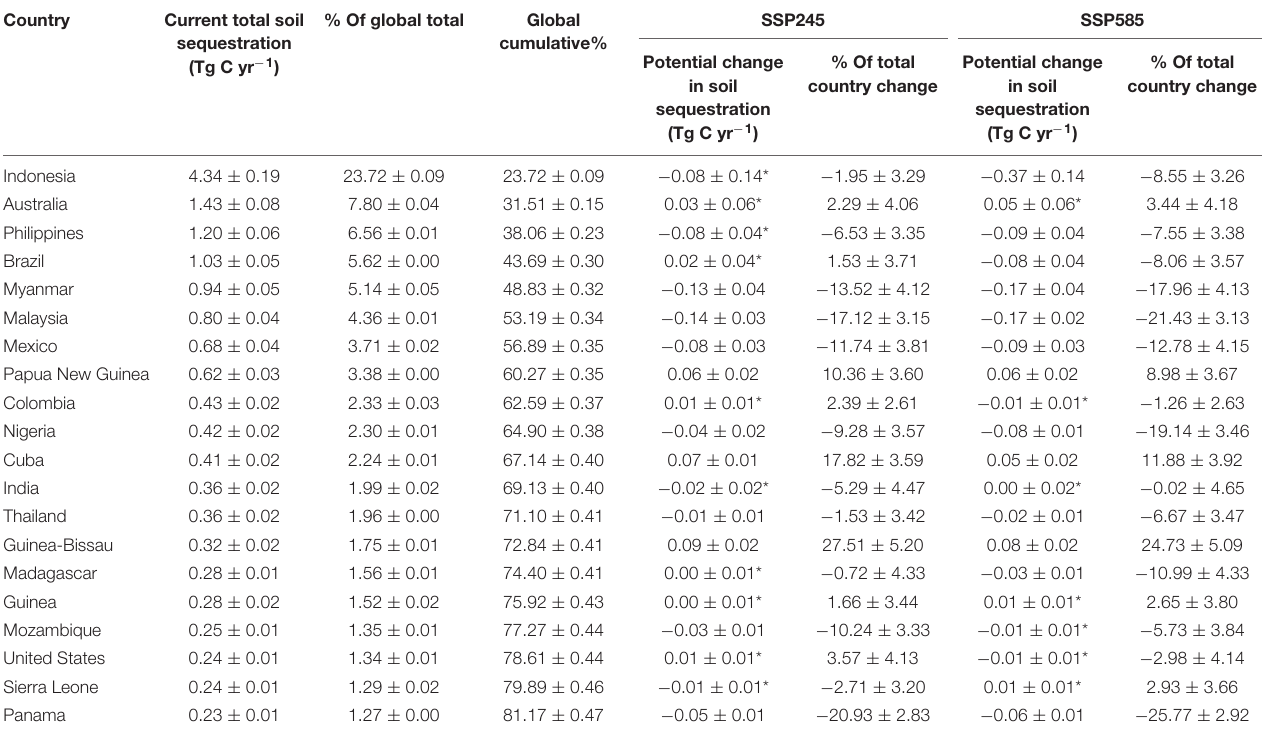
TABLE 2 | Mean ± 2 standard errors mangrove C sequestration rates of the 20 highest sequestering countries, and their forecasted gains under two climate scenarios (SSP245 and SSP585) based on bias-corrected and means-weighted forecasted climate data.